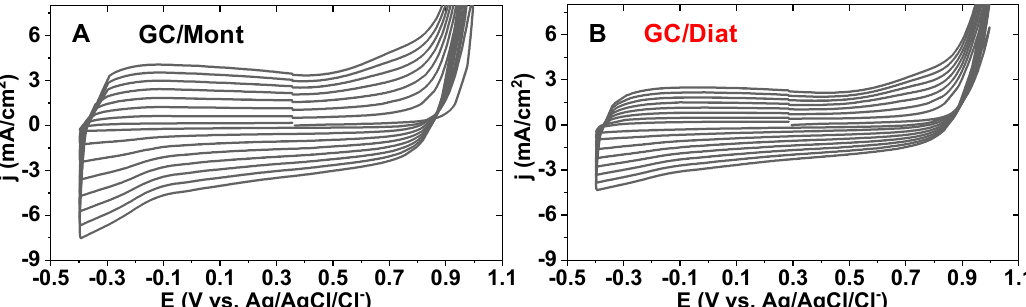
Figure 4. Successive cyclic voltammograms registered for the different GC/clay electrodes in a EDOT aqueous solution containing PSS. Anodic limit of 1.0 V. Scan rate = 100 mV/s.